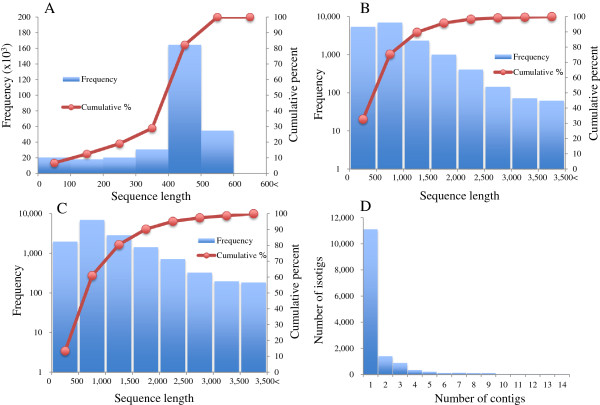
Summary of EST sequencing and de novo assembly. A) Size distribution and cumulative percentage of raw sequence reads. B) Size distribution and cumulative percentage of contigs. C) Size distribution and cumulative percentage of isotigs. D) Distribution of isotig sequence coverage.